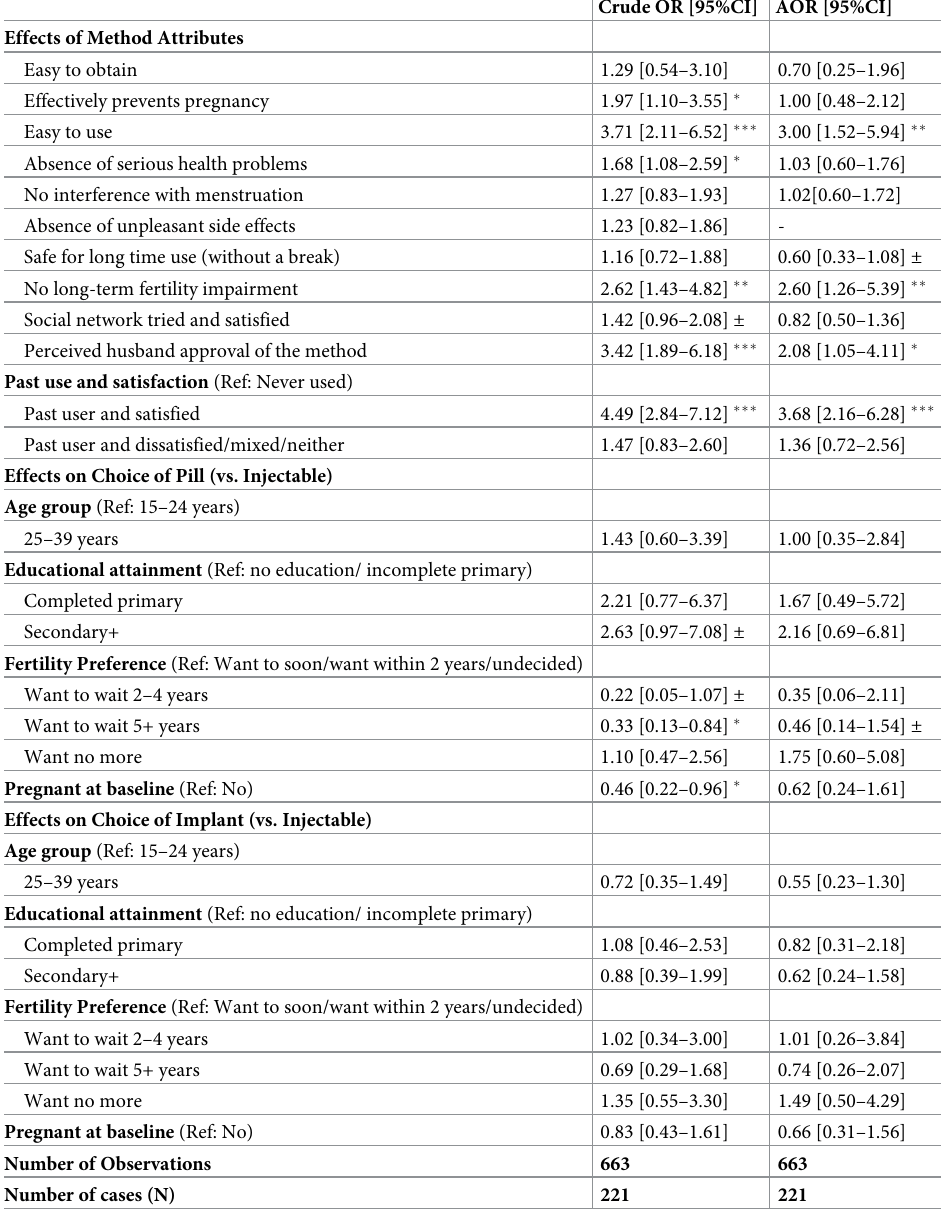
Table 3. Odds ratios (and 95% confidence intervals) from conditional logit regression analyses assessing women’s likelihood of using injectable, pill or implants at 12-month follow-up by perceived method attributes, past use and satisfaction, and selected characteristics